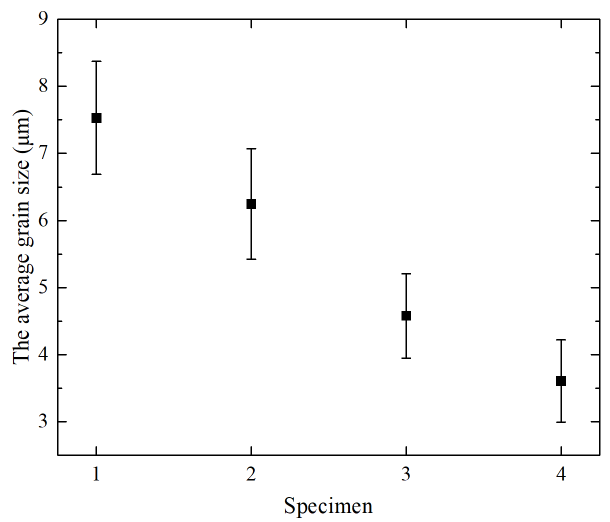
Figure 5. The average grain size of AM alloy.